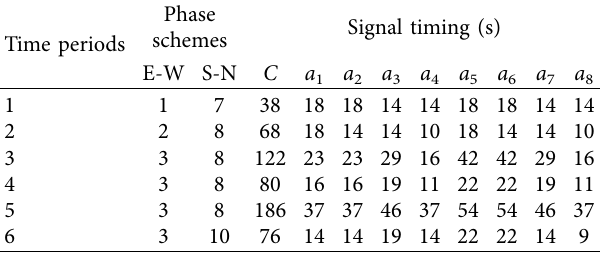
Table 6: Phase timing results of time periods of scheme